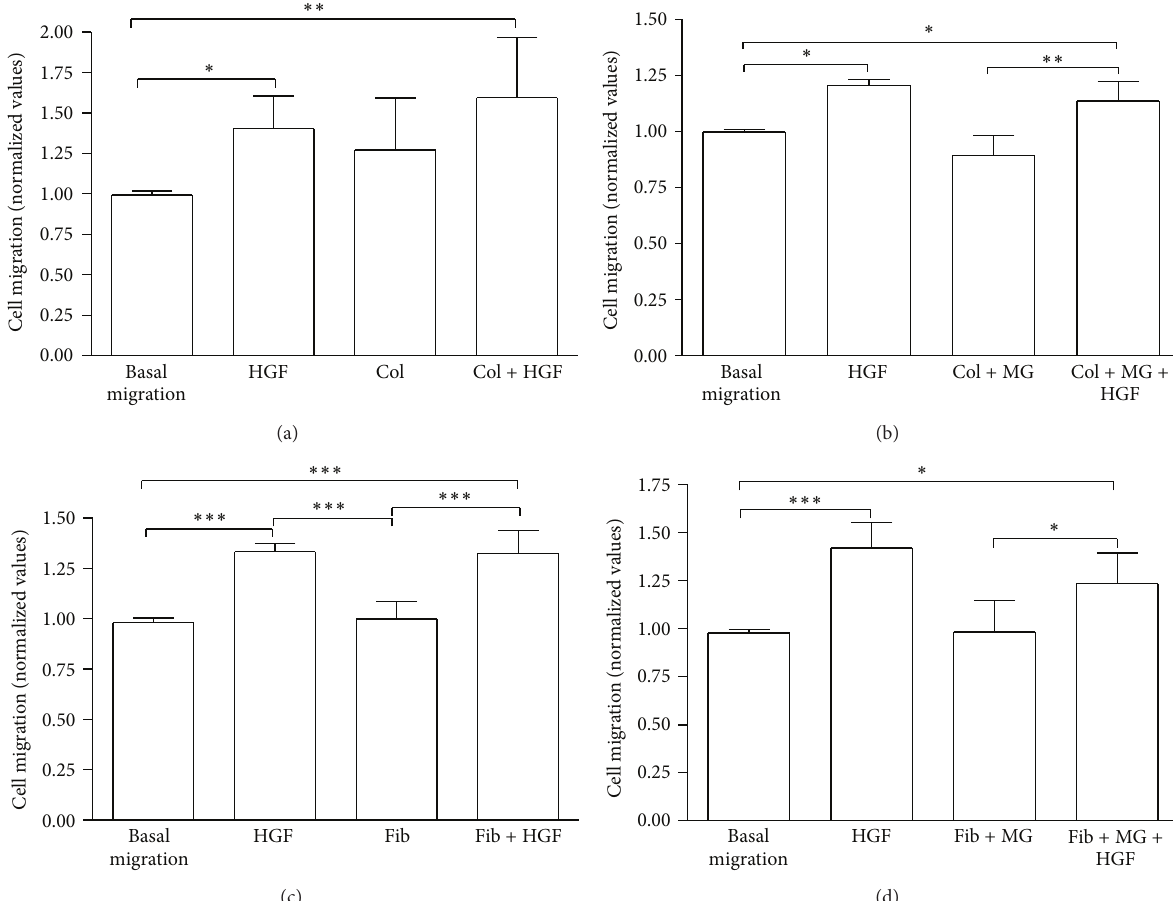
Figure 8: MSC migration towards biomaterials ± 75 ng/mL HGF. Migration assay ± HGF in (a) collagen and (c) fibrin. Invasion assay ± HGF + layer of Matrigel on (b) collagen and (d) fibrin. All values normalized to basal migration. ∗ 𝑃 < 0.05 , ∗∗ 𝑃 < 0.01 , ∗∗∗ 𝑃 < 0.001 . All results based on 𝑛 = 5